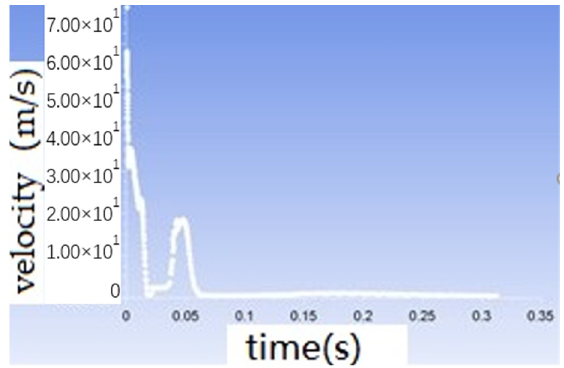
Figure 16. Velocity distribution of a single stone grain.